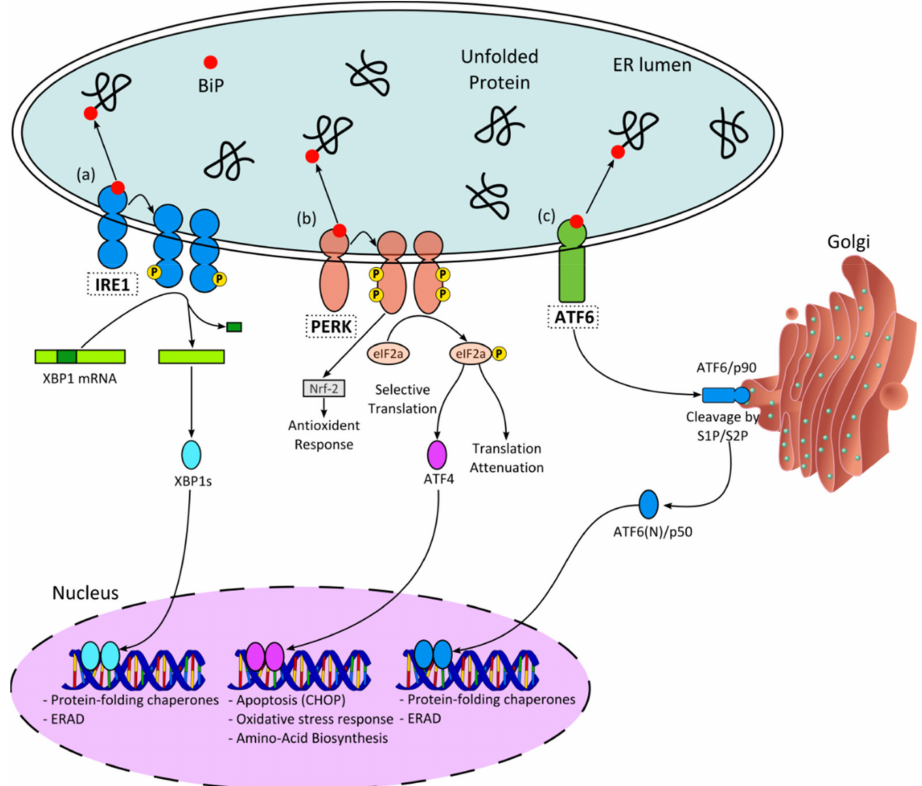
Figure 1. Mammalian UPR pathway: Upon ER stress, BiP dissociates from the ER membrane sensors IRE1, PERK, and ATF6, allowing activation of their downstream signalling cascades, including the unfolded protein response (UPR). ( a ) IRE1 dimerisation and autophosphorylation result in activation of an endoribonuclease activity that removes an intron in the mRNA encoding XBP1 transcription factor (TF). This reaction is essential for the translation of the active XBP1s TF, which induces UPR (i.e., chaperones) and non-UPR (ERAD) target genes. ( b ) PERK phosphorylates eIF2 α (p-eIF2 α ), leading to decreased protein synthesis (translation attenuation). Paradoxically, lower levels of eIF2 α promote translation of ATF4, a selective TF that drives expression of UPR target genes (e.g., CHOP). ( c ) ATF6 translocates from the ER to the Golgi apparatus, where it undergoes cleavage and results in the release of the active p50 fragment in the cytosol. The p50 translocates to the nucleus, where it binds to and activates the ERSE consensus sequence CCAAT-N9-CCACG found in the promoter of several UPR-target genes, including BiP, CCAAT/enhancer-binding protein (C/EBP) homologous protein (CHOP), and